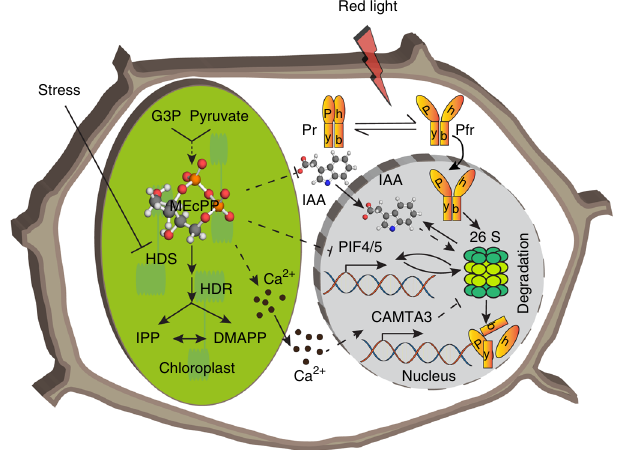
Fig. 9 Orthogonal regulation of phyB protein abundance by MEcPP. Stress interference with HDS enzyme activity and the consequential accumulation of MEcPP transduces intersecting signaling circuitries that regulate abundance of the red-light photoreceptor, phyB, via auxin signaling cascade and Ca 2 + -dependent CAMTA3-based transcriptional network. The likely function of CAMTA3 is to stabilize phyB protein levels through